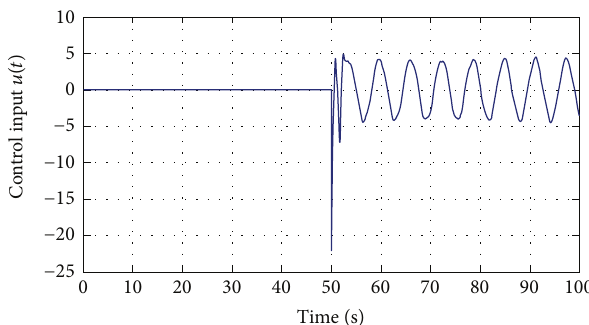
Figure 7: The control action versus time with control 𝑢(𝑡) activated at 𝑡 = 50